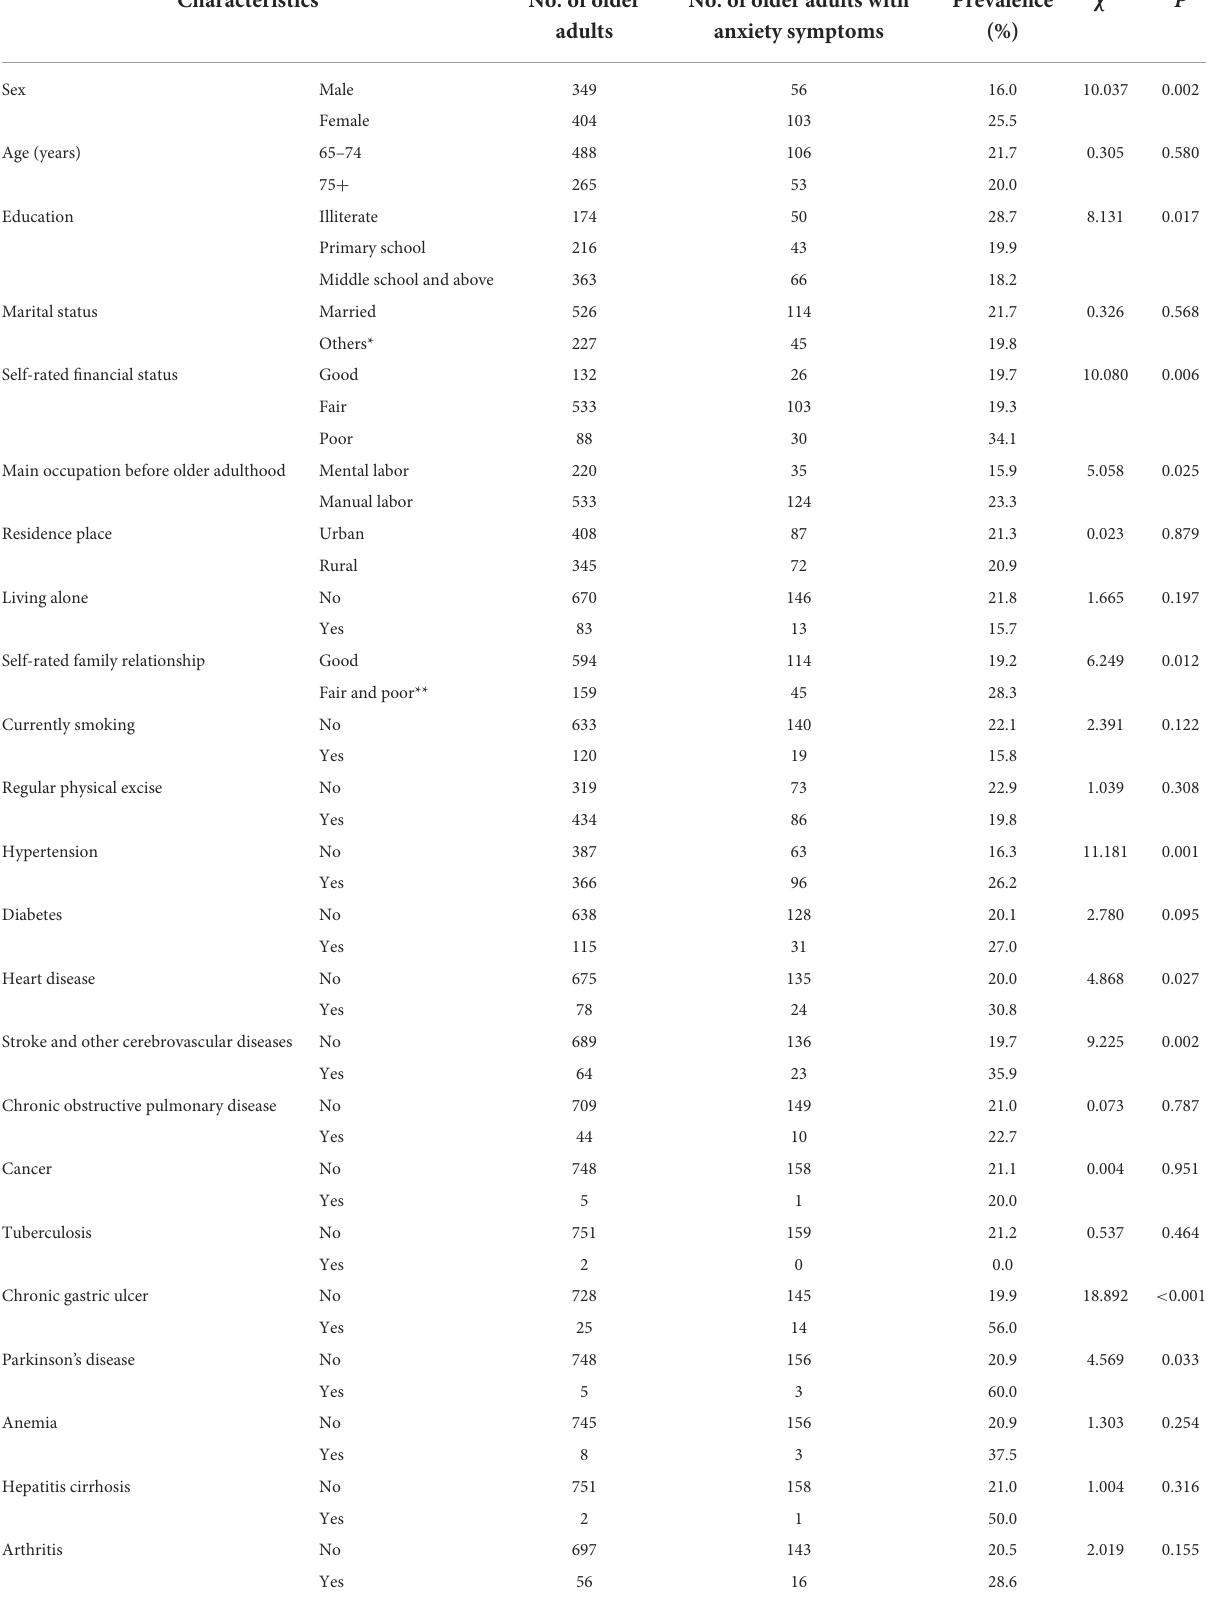
TABLE 1 Characteristics of the sample of older adults in primary care settings and prevalence rates of anxiety symptoms by sample characteristics. Characteristics No. of older